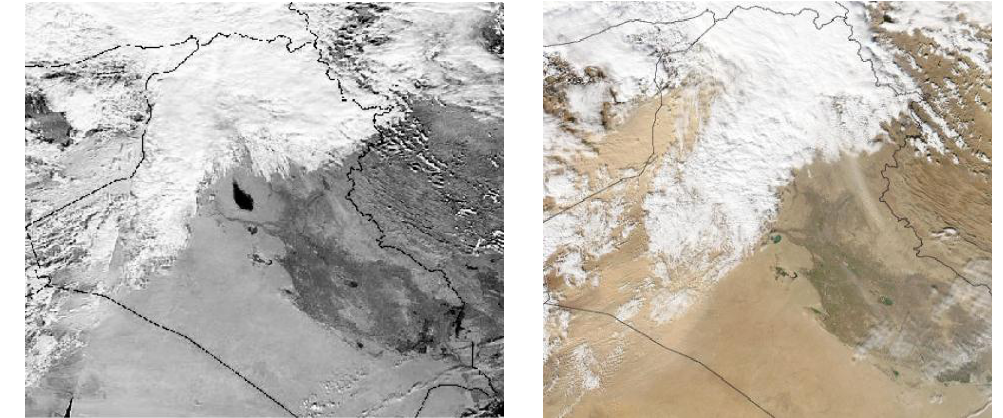
Fig. 2: Terra Modis satellite images (white and black, visible).